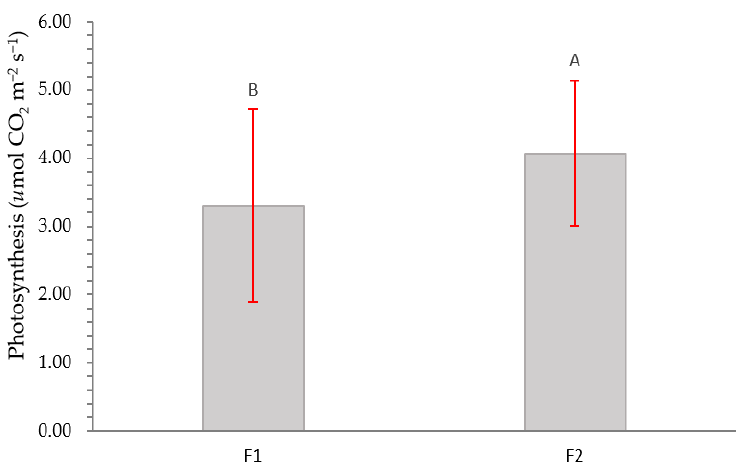
Figure 7. Net photosynthesis for Nothofagus alessandrii plants as a function of fertilization type. Different letters represent significant differences at p < 0.05.